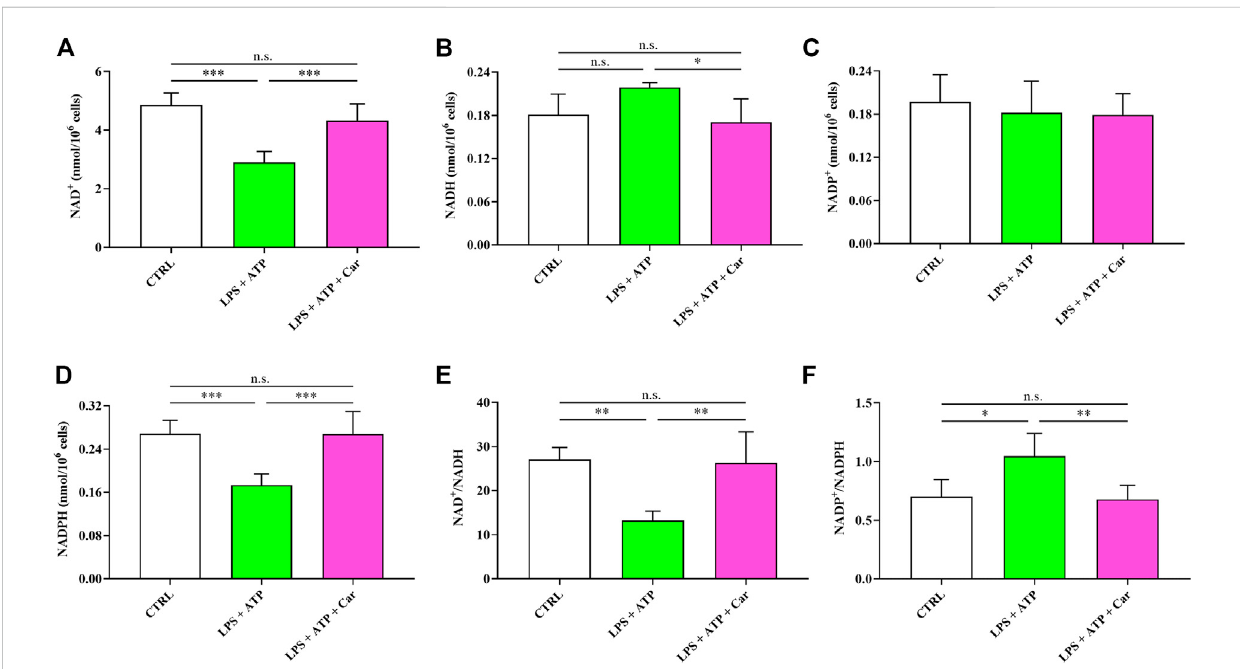
FIGURE 5 Values of oxidized (A, C) (NAD + and NADP + ) and reduced (B, D) (NADH and NADPH) nicotinic coenzymes determined in resting HMC3 cells and HMC3 cells exposed to LPS (100 ng/mL, 24 h) + ATP (5 mM, 30 min), in the absence or presence of carnosine (Car) (10 mM, 1 h pre-treatment). The oxidized/reduced ratios (E, F) are also shown. Data represent mean of four different samples. Standard deviations are represented by vertical bars. *Signi fi cantly different, p < 0.05; **Signi fi cantly different, p < 0.01; ***Signi fi cantly different, p <